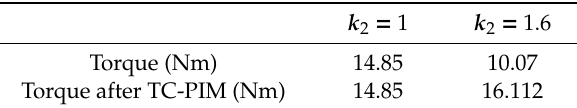
Figure 13. ( a ) Comparison of motor status. ( b ) Comparison of motor torque. ( c ) Comparison of motor torque at power-assist region. ( d ) Gear position. Table 7. Simulated torque convert values.